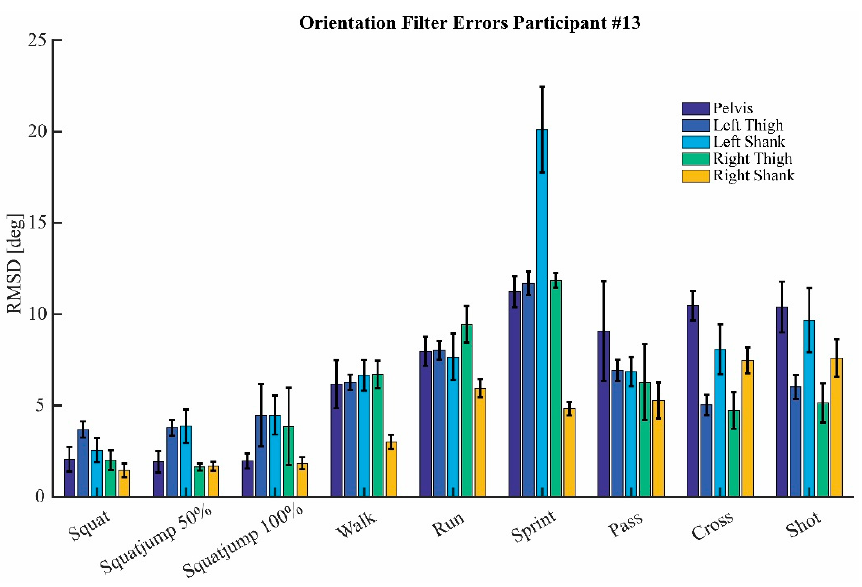
Figure A6. Error caused by the orientation filter of a typical subject. Mean root-mean-square differences (RMSD) and standard deviations for all body segments and all trials.